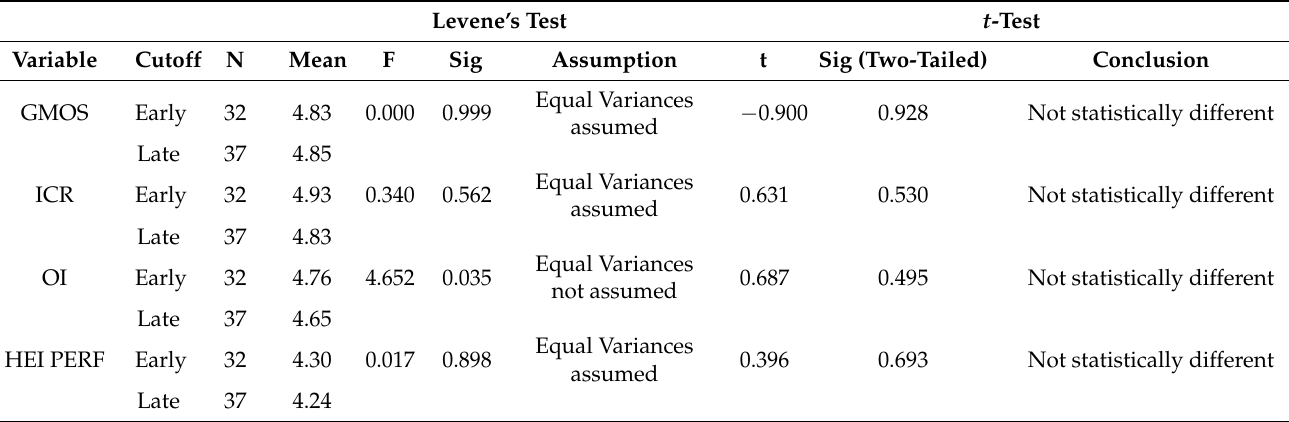
Table 2. Levene test and Independent t